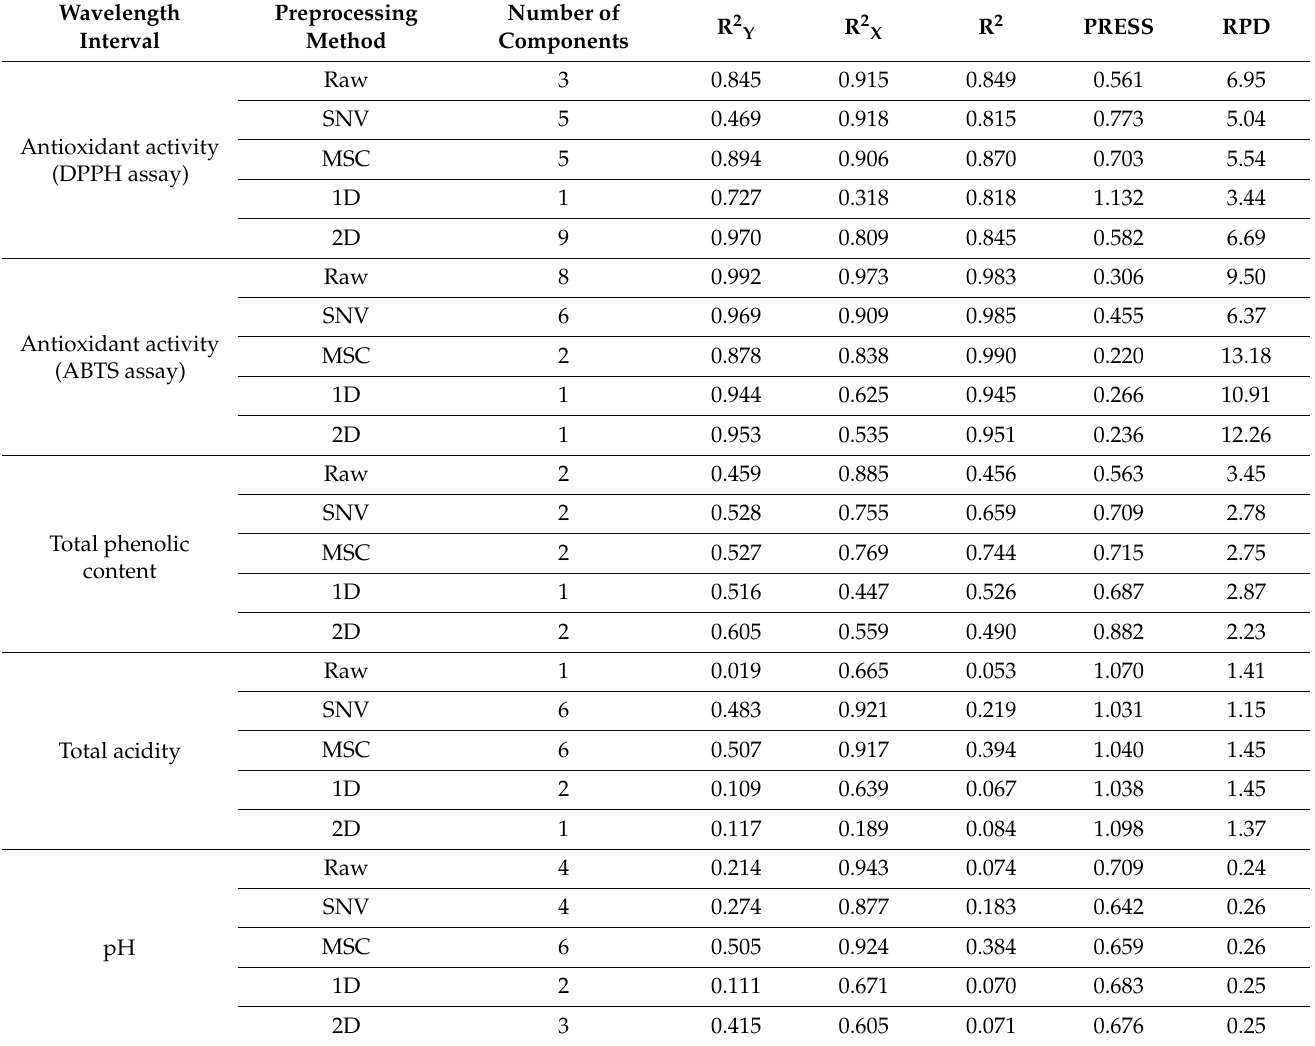
Table 3. Statistical performance of the partial least squares regression (PLSR) models built for the prediction of the chemical properties of vinegars using the UV-Vis spectral